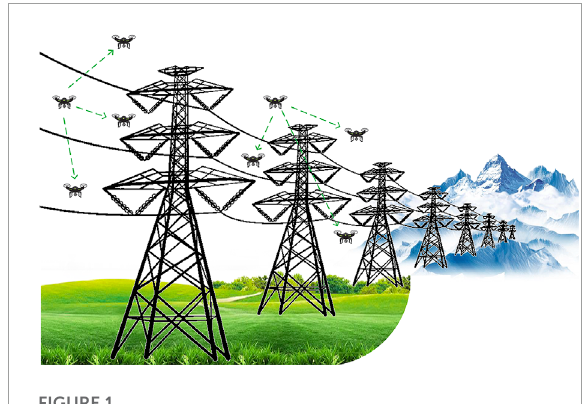
FIGURE 1 Multi-agent grid inspection systems application scenario